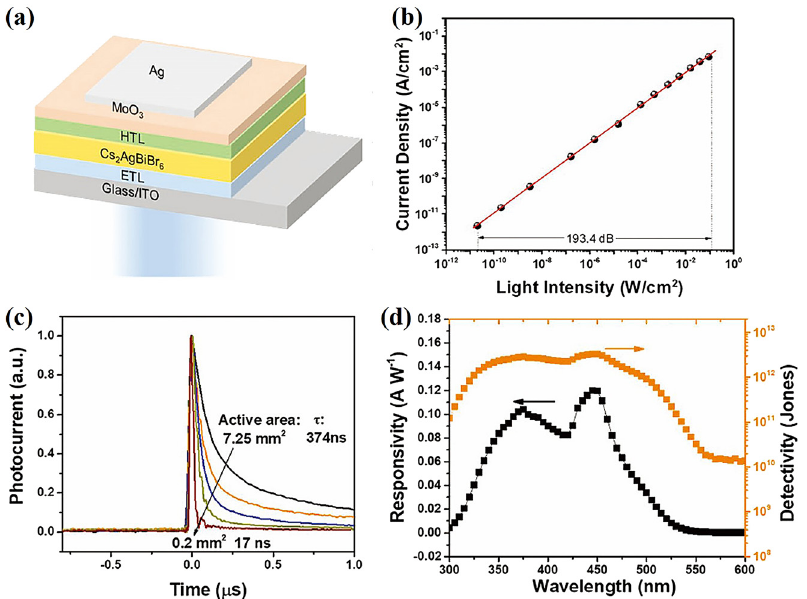
semiconducting properties, which render them suitable for the application in ultraviolet detectors. Cu-based perov- skite is a typical example, with a formula of Cs schematic view of the crystal structure thereof is shown in Figure 6a. The crystallographic phase fi ngerprinted by XRD measurement indicates an orthorhombic phase of Cs (Figure 6b) [98, 99], where there are two types of Cu + sites, namely a tetrahedral site and a trigonal site (the pink